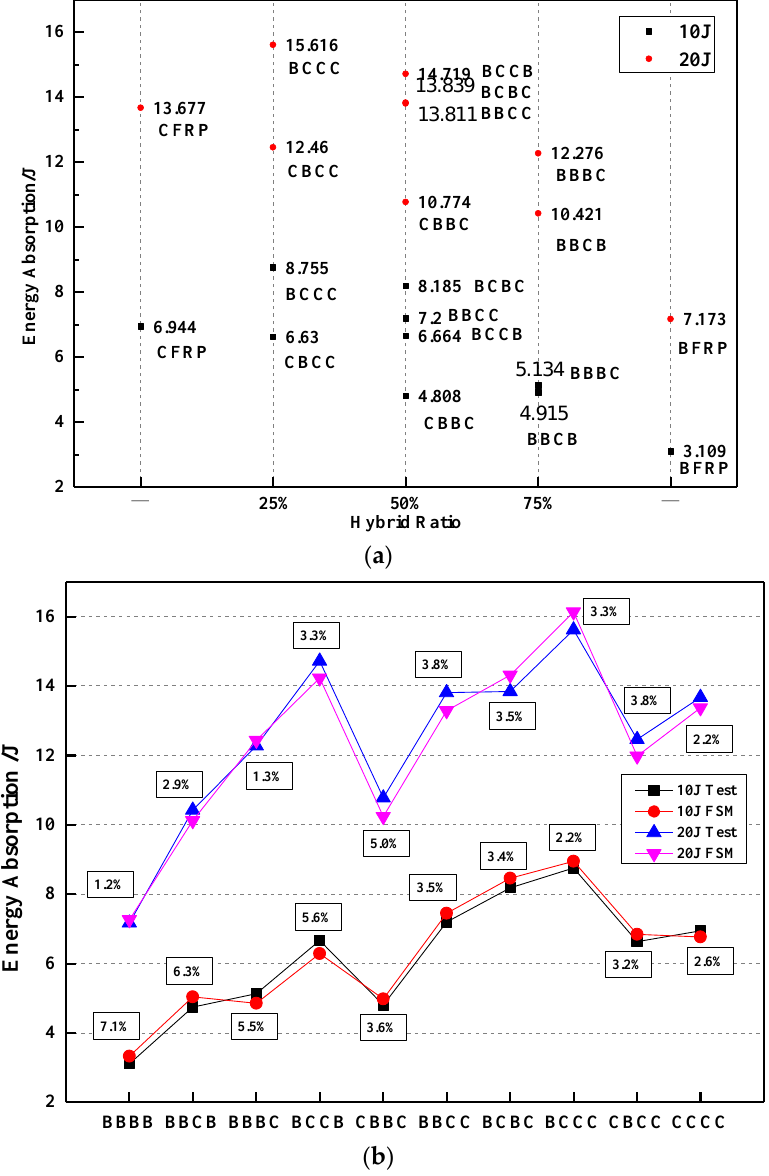
Figure 6. Energy absorption of ( a ) different impact laminates and ( b ) trend curve and comparison diagram of FEM and test.